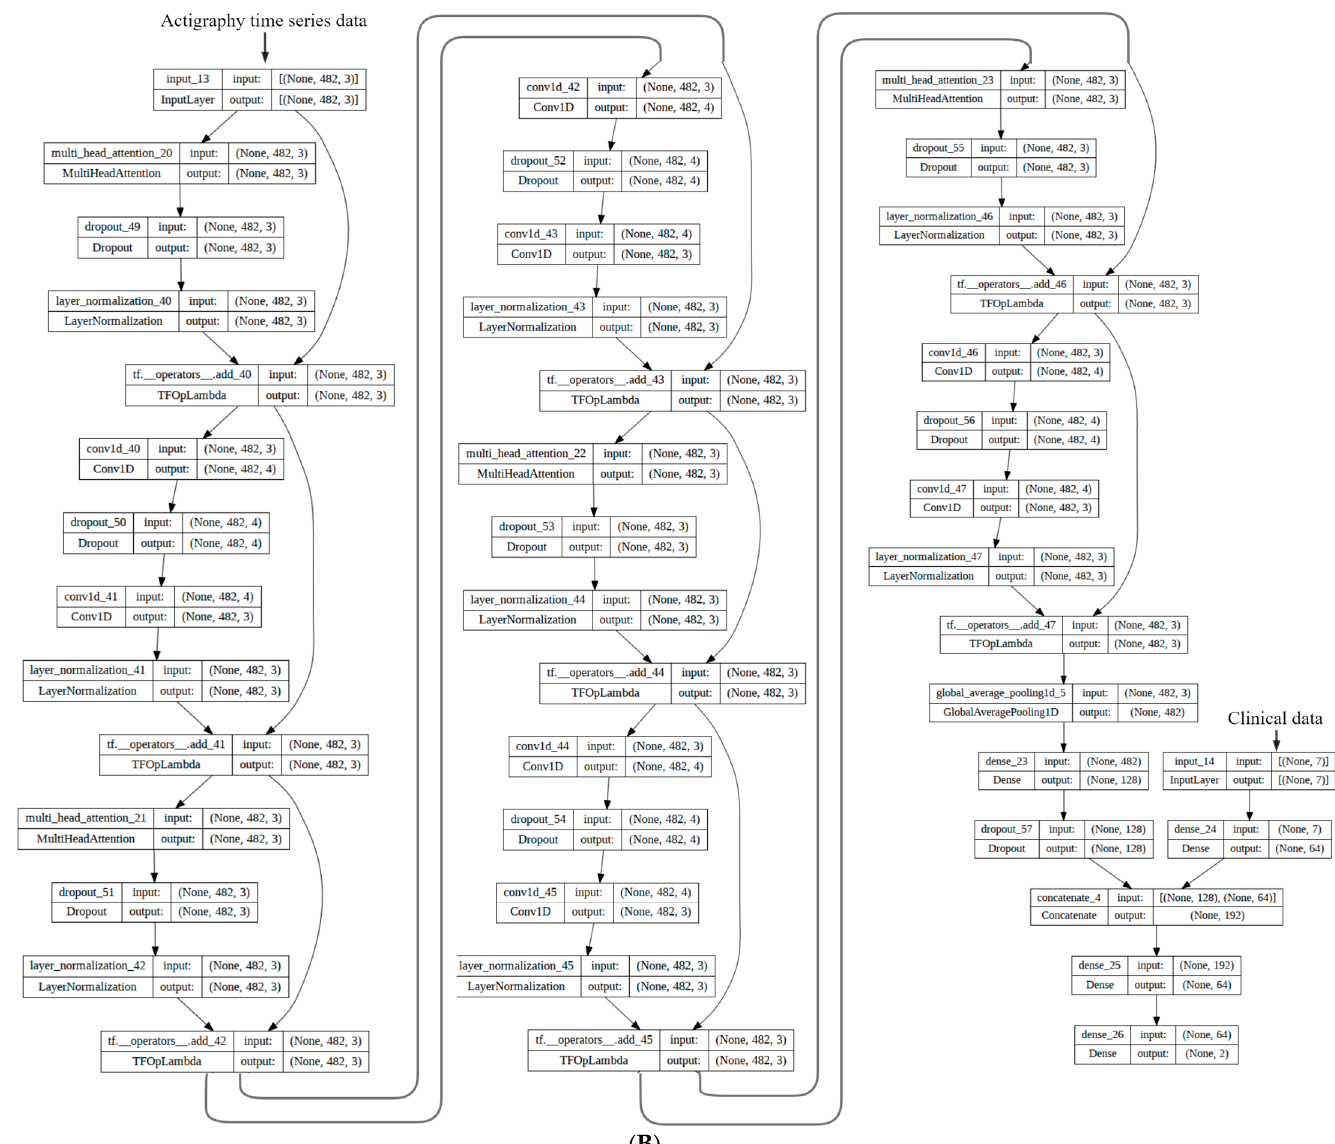
Figure A10. Configuration of transformer model. ( A ) Time series data and ( B ) time series and clinical data.